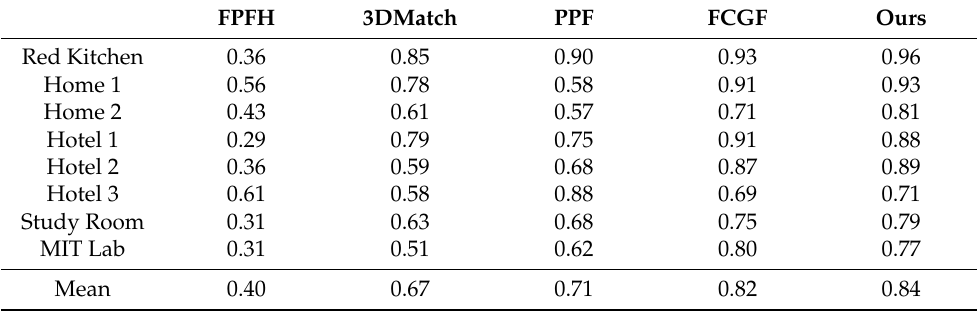
Table 3. Comparison of registration recall rates between our model and other advanced models.